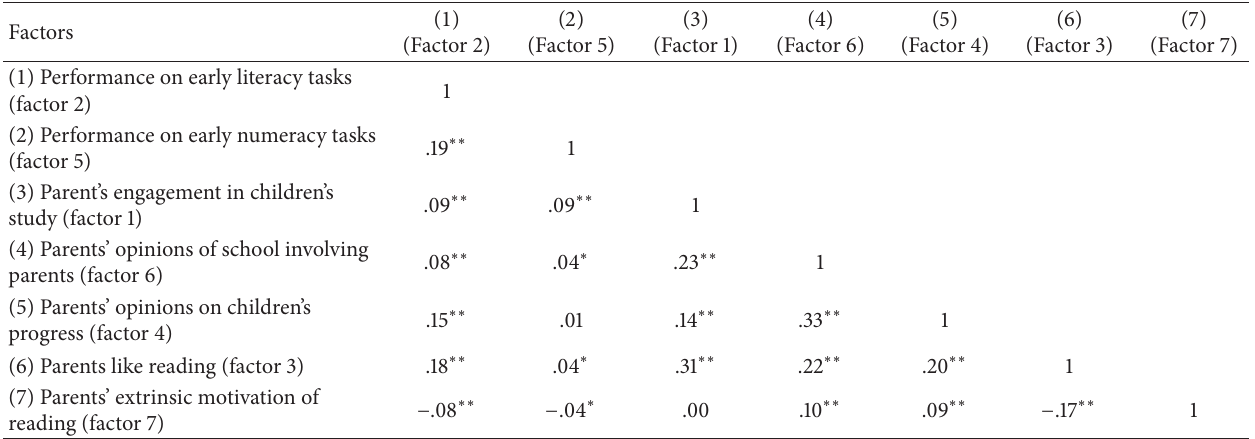
Table 5: Correlations among the seven factors.